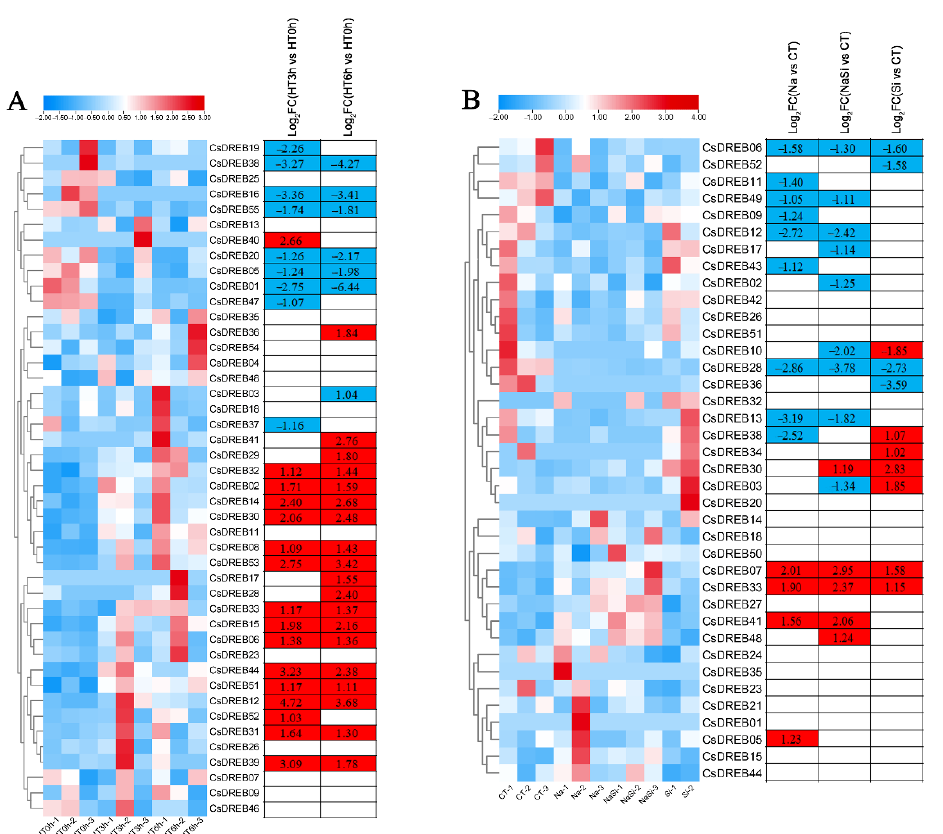
Figure 8. Expression profiles of CsDREB genes in response to various abiotic stress treatments: The transcriptional levels of CsDREB genes in response to heat ( A ) and salt ( B ) stresses are shown on the heatmap. A range of − 3.00 to 3.00 was artificially set with the color scale limits according to the normalized values. The color scale shows increasing expression levels from blue to red. CT, control treatment; HT, heat treatment; HT0h, heat treatment for 0 h (hours); HT3h, heat treatment for 3 h; HT6h, heat treatment for 6 h; FC, fold-change.